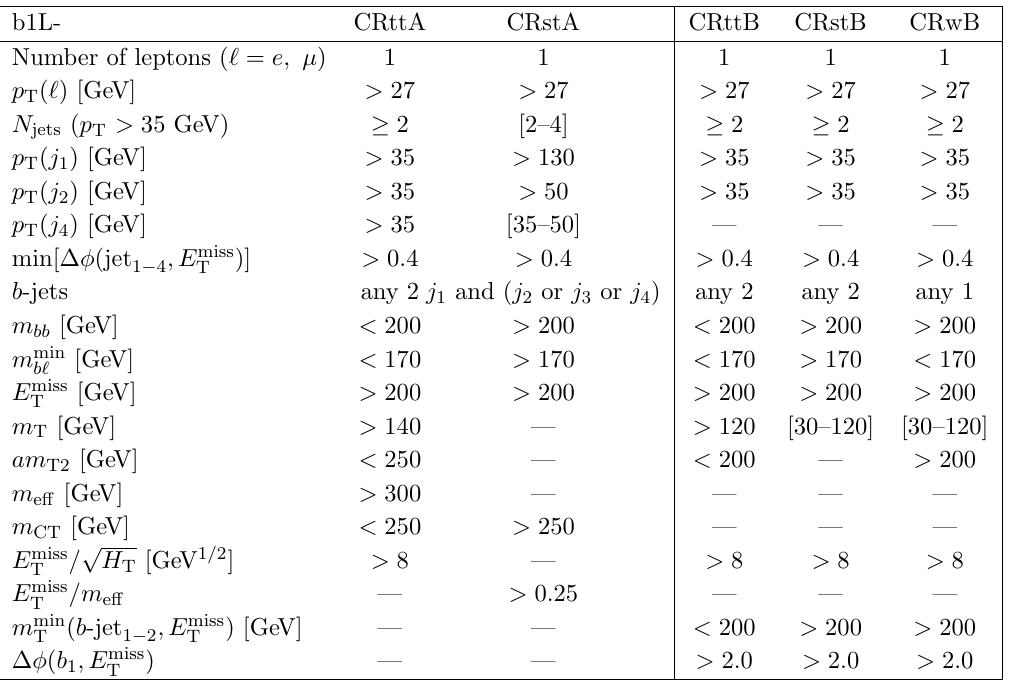
Table 5. Summary of the event selection in each control region corresponding to the b1L signal regions. The term lepton is used in the table to refer to signal electrons and muons. Jets ( j 1 , j 2 , j 3 and j 4 ) are labelled with an index corresponding to their decreasing order in p T .